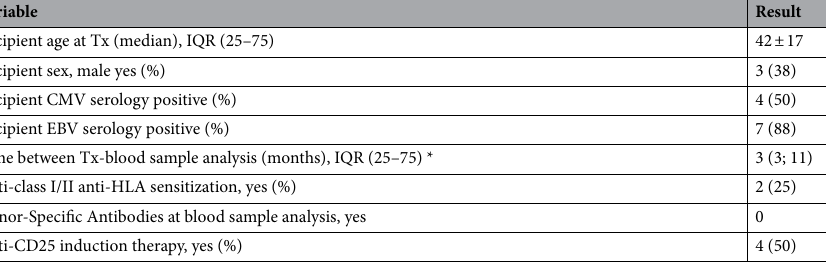
Table 3. Main characteristics of the 11 patients included for the donor-specific response analyses. *One patient provided blood samples for investigation at 0.5, 1-, and 3-months post-transplantation, and one other patient provided blood samples for investigation at 3- and 6-months